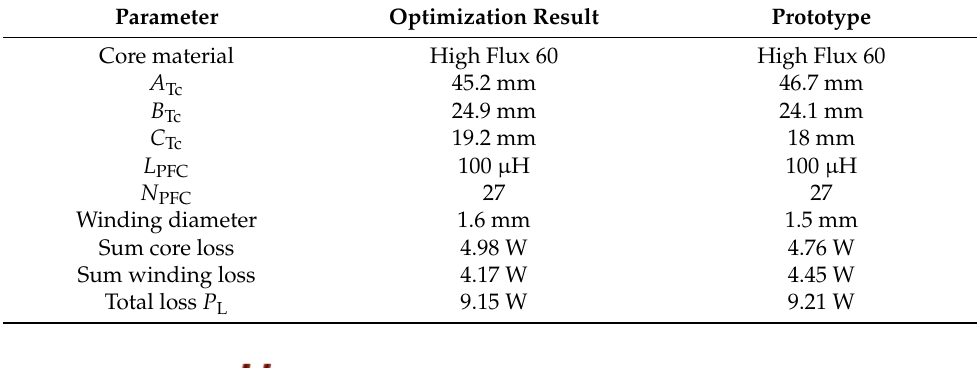
Figure 11. Loss P L versus inductance L PFC of the PFC coil for different permeabilities at f sw,PFC = 140 kHz and V Tc = 30 cm³. Table 5. Optimization results and values of the prototype of the PFC coil.